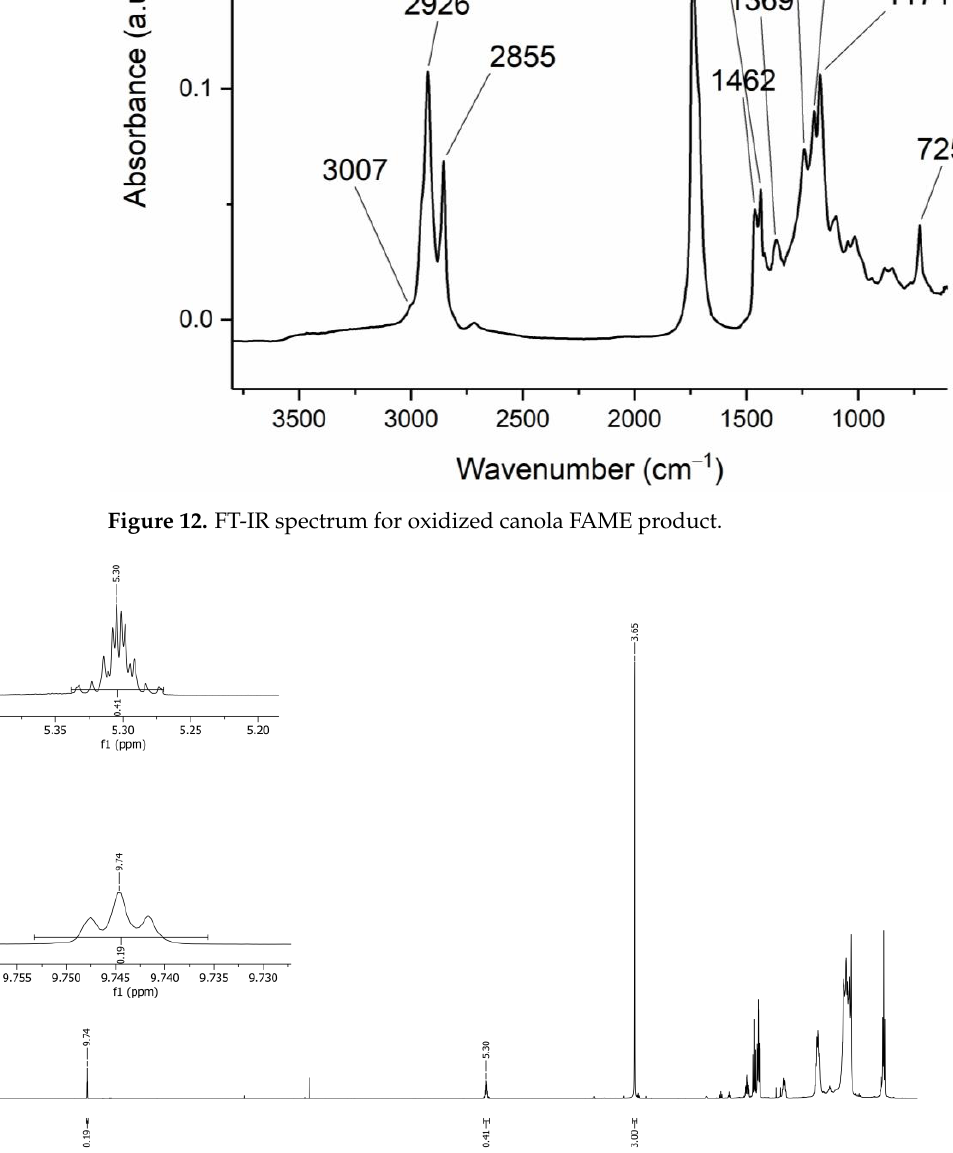
Figure 14. 13 C NMR spectrum for oxidized canola FAME product.